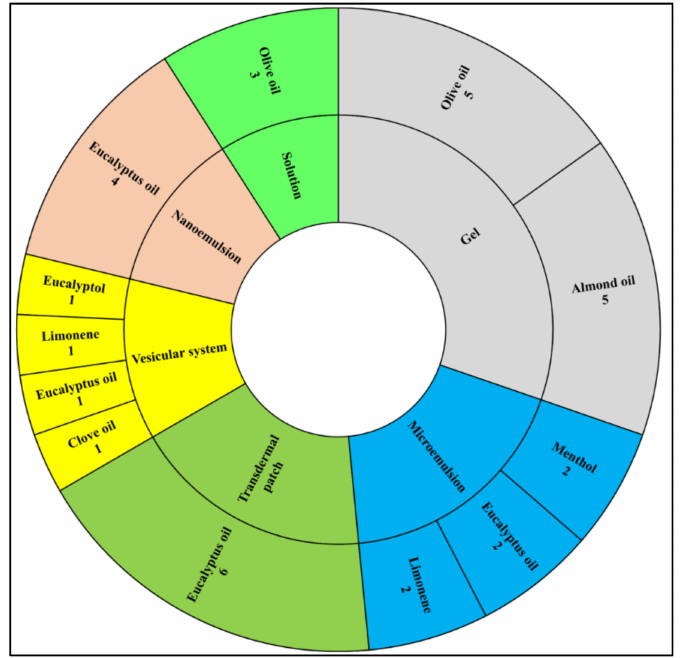
Figure 5. The most frequent essential and carrier oils used in the most frequent dosage forms from all eligible articles.